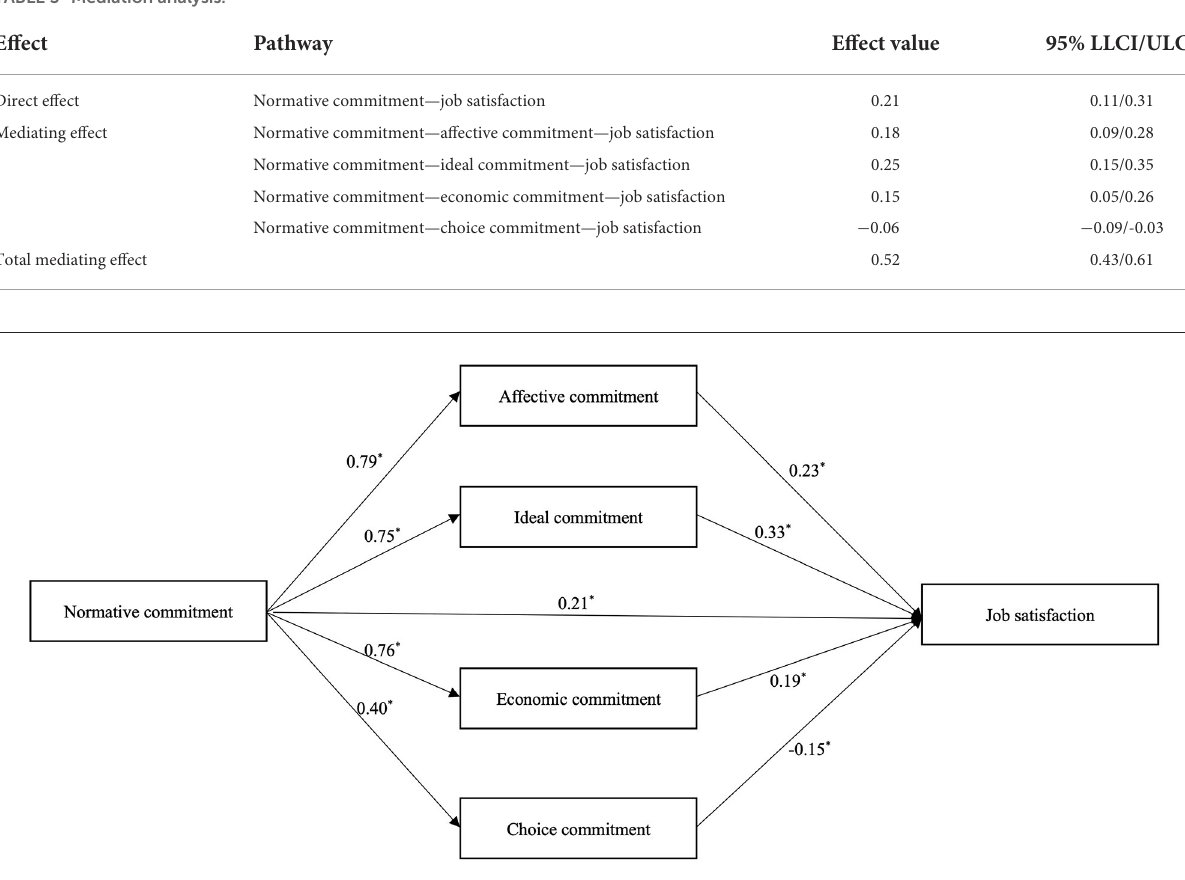
FIGURE2 Mediation model of organizational commitment and job satisfaction. *: P < 0.001.